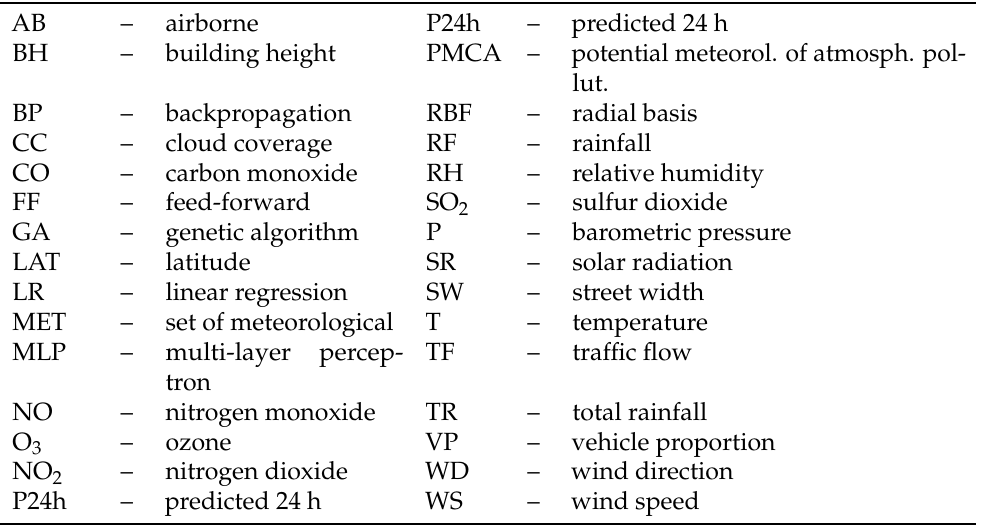
Table 2. Abbreviations of frequently used